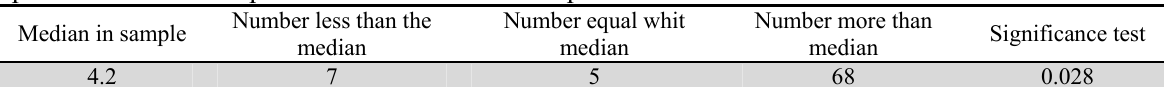
Sign test for Variable of Iran’s membership in WTO effects on Increase of scientific and professional power in the field of production of handmade